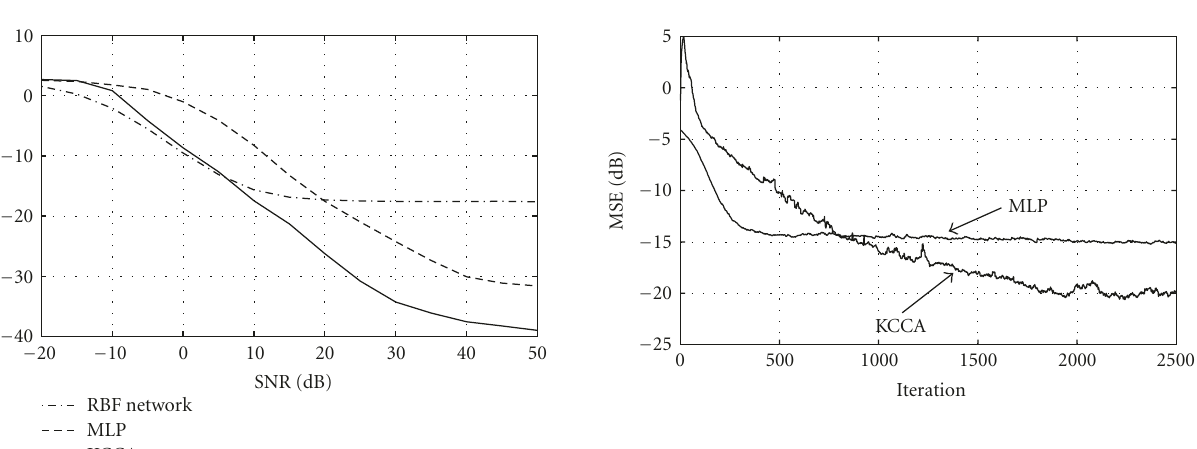
Figure 10: MSE e 2 [ n ] for full system identification of the Wiener y system, using a black-box method (MLP) and the proposed KCCA